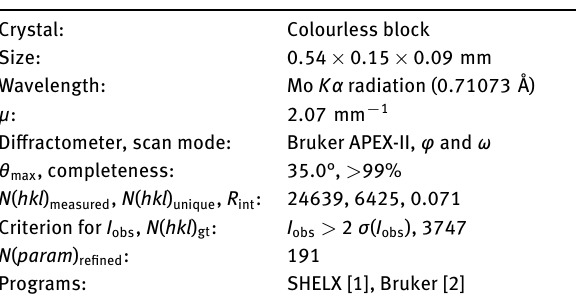
Table 1: Data collection and handling.